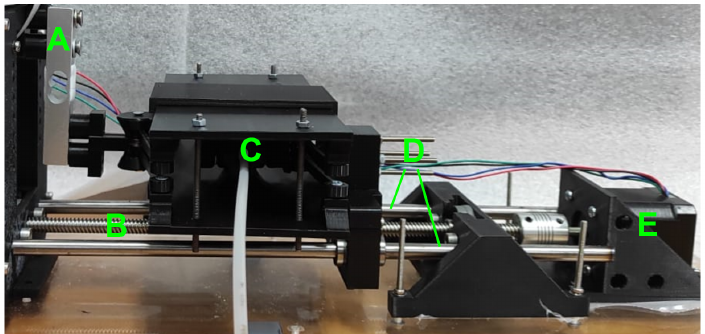
Figure 8. Experimental test-rig during the tests of the hybrid actuator. ( A ) load cell; ( B ) ball screw drive; ( C ) hybrid actuator; ( D ) linear guides; and ( E ) stepper motor.